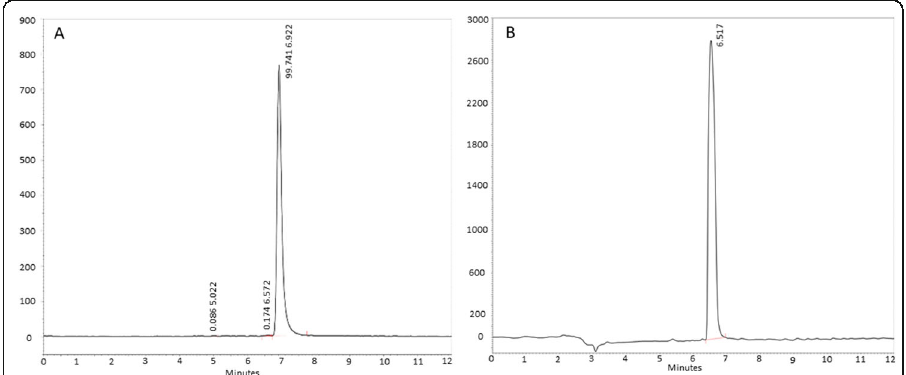
Fig. 3 a Radio-HPLC Chromatogram of [ 68 Ga]Ga-FAPI-46 b UV-HPLC Chromatogram of [ nat